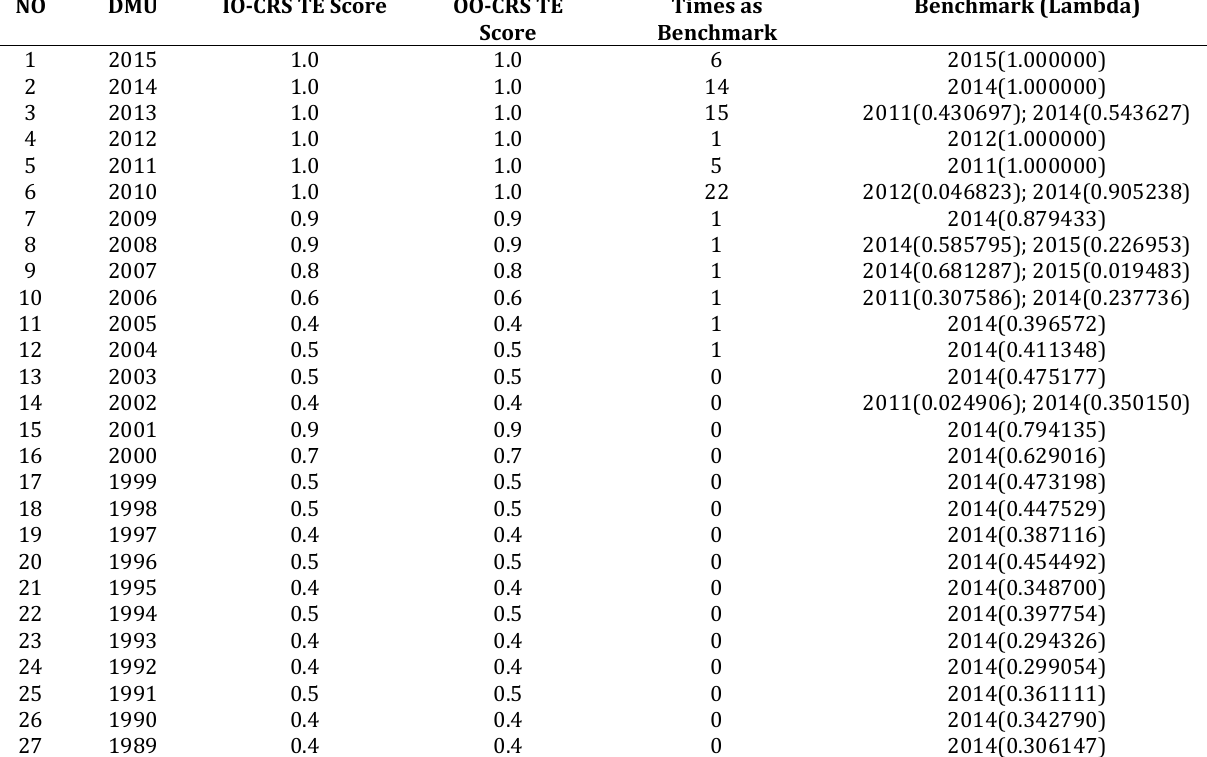
Table 5: Input-Oriented Technical Efficiency Benchmarking for Lagos Port